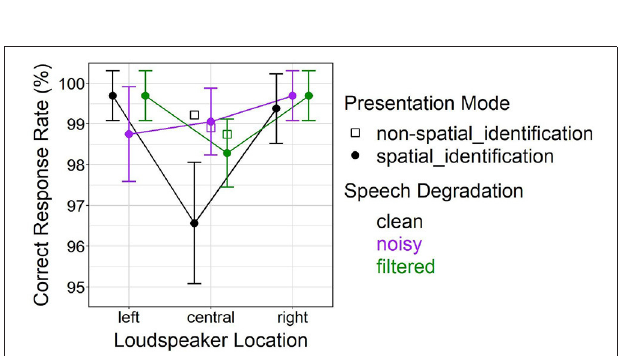
FIGURE 7 | Effects of presentation mode and speech degradation on correct response rate in the spatial_id mode. Open square-shaped points represent the non-spatial_id mode only (involving presentations only at the central loudspeaker location). Error bars represent 95% confidence